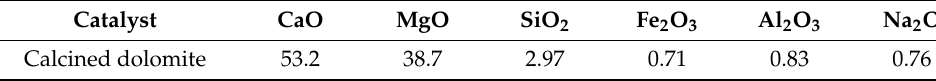
Table 4. Chemical analysis of calcined dolomite (wt%). Figure 6. XRD patterns of dolomite (1) and calcined dolomite (2).